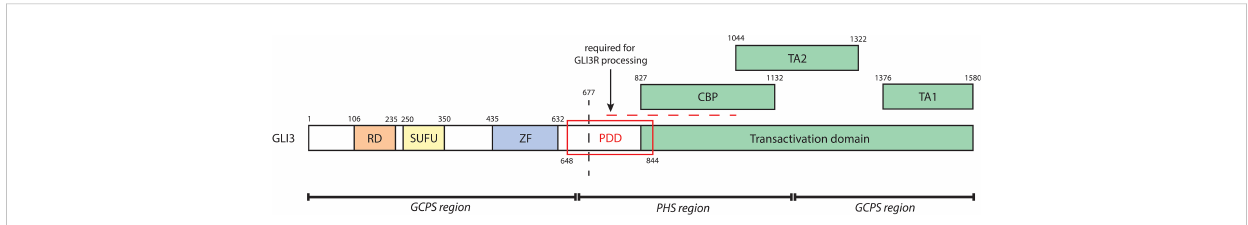
FIGURE 5 A schematic of biochemical domains of human GLI3 containing the repressor domain (RD, a.a. 106-235), SUFU-binding domain (SUFU, 250-350), zinc fi nger DNA-binding domain (ZF, a.a. 435-632), and transactivation domain (a.a. 827-1580). The transactivation domain, which is critical to GLI3A, contains a CREB-binding protein domain (CBP, a.a. 827-1132), transactivation domain 2 (TA2, a.a. 1044-1322), and transactivation domain 1 (TA1, a.a. 1376-1580). The processing determinant domain (PDD, a.a. 648-844) is critical to the proteolytic cleavage of GLI3. The horizontal dashed line further denotes a series of sites required for GLI3R processing; GLI3 is phosphorylated at its PKA sites (a.a. 849, 869, 877, 907, 980, 1006) and GSK3 b sites (a.a. 861, 873, 903). This leads to binding of b TrCP (at GLI3 a.a. 856, 864, 855, 894) and subsequent ubiquitination by SCF TrCP (at GLI3 a.a. 773, 779, 784, 800), causing proteolytic cleavage (indicated by the vertical dashed line) and thus generation of GLI3R. Regions of mutagenesis of GLI3 associated with either GCPS (a.a. 1-660, 1160-1580) or PHS (a.a. 661-1159) are indicated at the